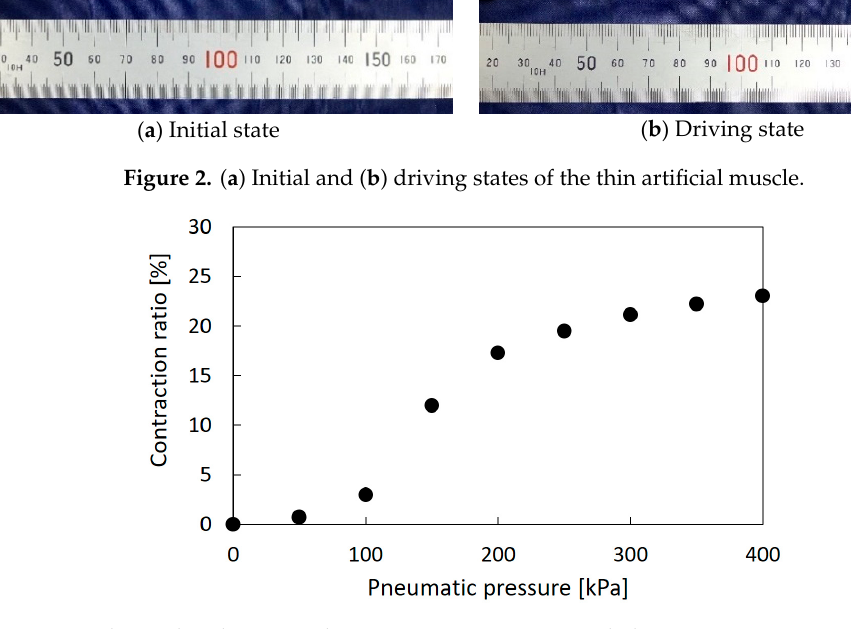
Figure 3. Relationship between the pneumatic pressure and the contraction ratio of the thin artificial muscle.